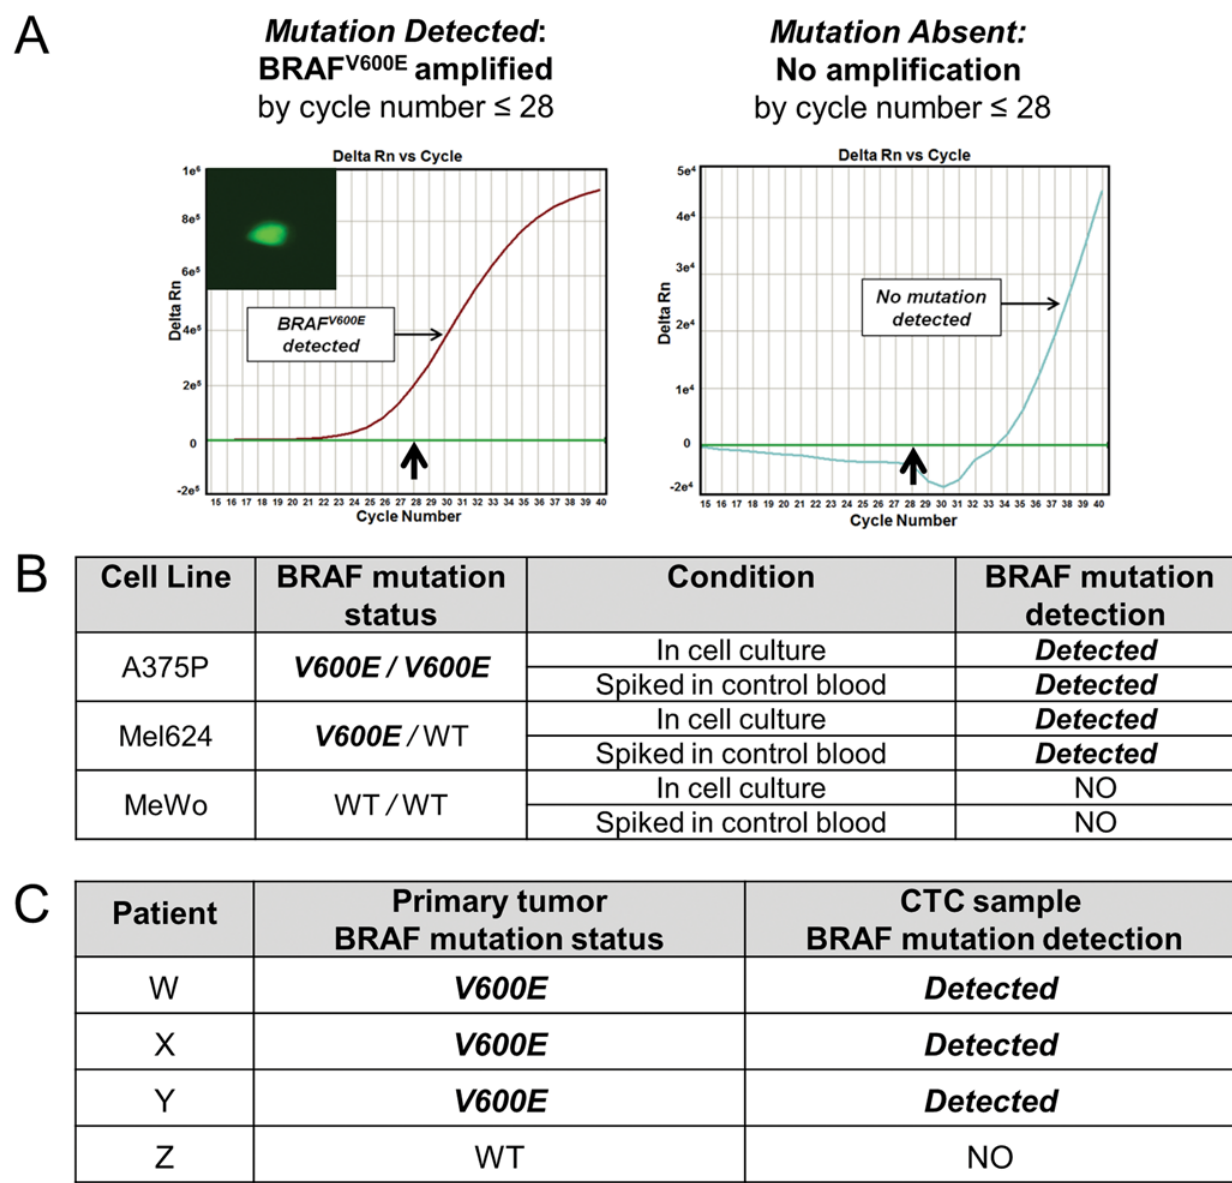
Fig 4. Detection of BRAF mutations in isolated melanoma cells in culture and in CTCs from melanoma patients. (A) PCR results indicating the presence or absence of the BRAF V600E mutation. Cells exposed to the probe and rendered fluorescent (left inset) were isolated via capillary-based methods. Whole genome amplification (WGA) was performed on the DNA extracted from each cell, followed by quantitative polymerase chain reaction (qPCR) analysis using primers specific for the BRAF V600E mutation. The presence of the mutation results in signal (Delta Rn, Y-axis) detectable by the 28th cycle and a curve of the characteristic “ s ” shape (left, arrow points to 28th cycle). The absence of the mutation results in no characteristic curve by the 28th cycle (right, arrow points to 28th cycle). (B) Isolation and genetic analysis for mutated BRAF V600E in melanoma cells in culture and spiked in control blood. A375P (homozygous BRAF V600E mutated), Mel624 (heterozygous BRAF V600E mutated), and MeWo (homozygous BRAF WT) cells were isolated in culture and after being spiked into control blood using the capillary-based technique described. The DNA was extracted from each cell and subject to WGA, followed by qPCR analysis with primers specific for the BRAF V600E mutation. In each case, the qPCR analysis accurately confirms the presence or absence of the BRAF V600E mutation for each cell line. (C) Isolation of CTCs from patients and subsequent genetic analysis for BRAF mutation status. CTCs were isolated from an additional cohort of patients via capillary-based methods followed by DNA extraction, WGA, and qPCR analysis for BRAF V600E . In each case, the BRAF mutation status of the isolated CTCs corresponded to that of the primary tumor.